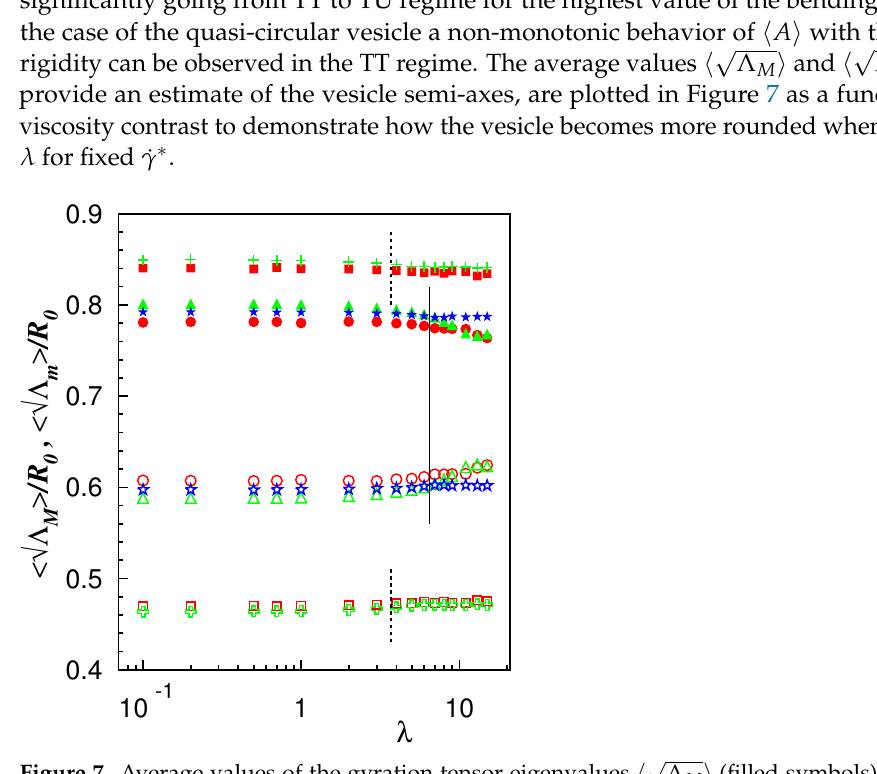
Figure 7. Average values of the gyration tensor eigenvalues (cid:104) (empty symbols) as a function of λ at S ∗ = 0.80 for κ / ( k B TR 0 ) = 6.58 ( (cid:3) ), 65.8 ( + ), and at S ∗ = 0.95 for κ / ( k B TR 0 ) = 6.58 ( • ), 65.8 ( (cid:78) ), 164.5 ( (cid:63) ). The tank-treading to tumbling transition in the Keller– Skalak theory [5] is marked by the dashed ( S ∗ = 0.80) and full ( S ∗ = 0.95) vertical